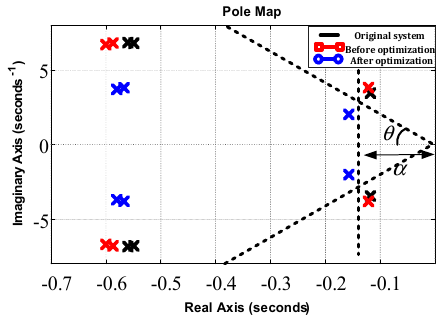
Figure 7 . The eigenvalues of the system before/after optimization.